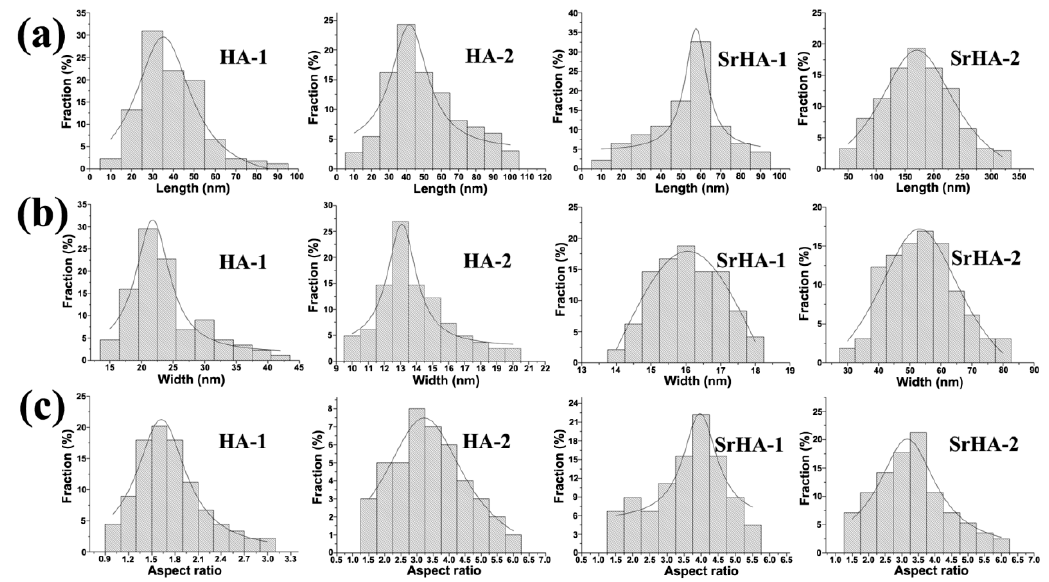
Figure 5. ( a ) Length distribution of HA and SrHA; ( b ) Width distribution of HA and SrHA; ( c ) Aspect ratio distribution of HA and SrHA.